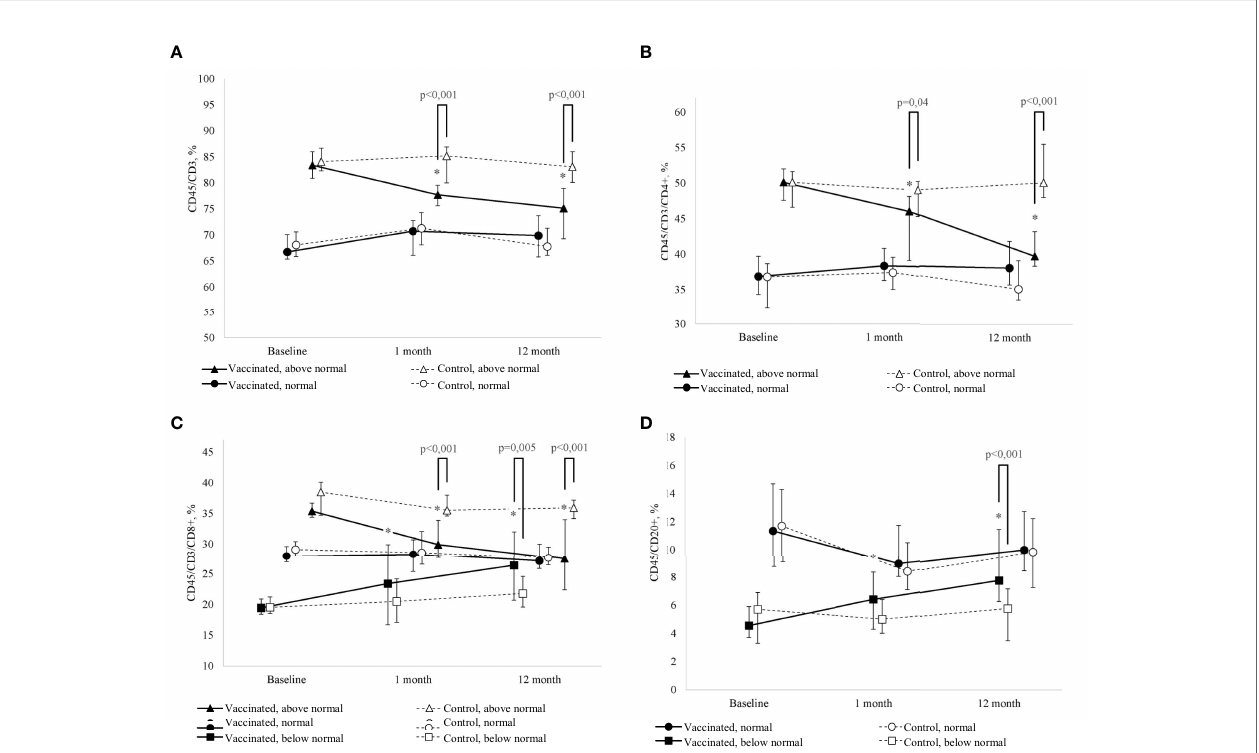
FIGURE 2 | (A) Change in the percentage of T-lymphocytes (CD45/CD3+) of peripheral blood in dynamics in children with GN in the study group (after revaccination with DT toxoid – n = 25) and the control group (n = 20); the median and interquartile range are given: Me (Q1-Q3). * – statistically signi fi cantly different from the pre- vaccination value (p < 0.05). Tukey's test was used in a linear mixed effects model. (B) Change in the percentage of T-helpers (CD45/CD3/ С D4+), of peripheral blood in children with GN in the study group (after revaccination with DT toxoid – n = 25) and the control group (n = 20); the median and interquartile range are given: Me (Q1-Q3). *p ≤ 0.05 – compared to the pre-vaccination level (p ≤ 0.05). Tukey's test was used in a linear mixed effects model. (C) Change in the percentage of cytotoxic T- lymphocytes (CD45/CD3/CD8+) of peripheral blood in dynamics in children with GN in the study group (after revaccination with DT toxoid – n = 25) and the control group (n = 20); the median and interquartile range are given: Me (Q1-Q3). #* – statistically signi fi cantly different from the pre-vaccination value (p ≤ 0.05). Tukey's test was used in a linear mixed effects model. (D) Change in the percentage of B-cells (CD45/CD20+) of peripheral blood in dynamics in children with GN in the study group (after revaccination with DT toxoid – n=25) and the control group (n=20); the median and interquartile are given: Me (Q1-Q3). * – statistically signi fi cantly different from the pre- vaccination value (p ≤ 0.05). Tukey ’ s test was used in a linear mixed effects